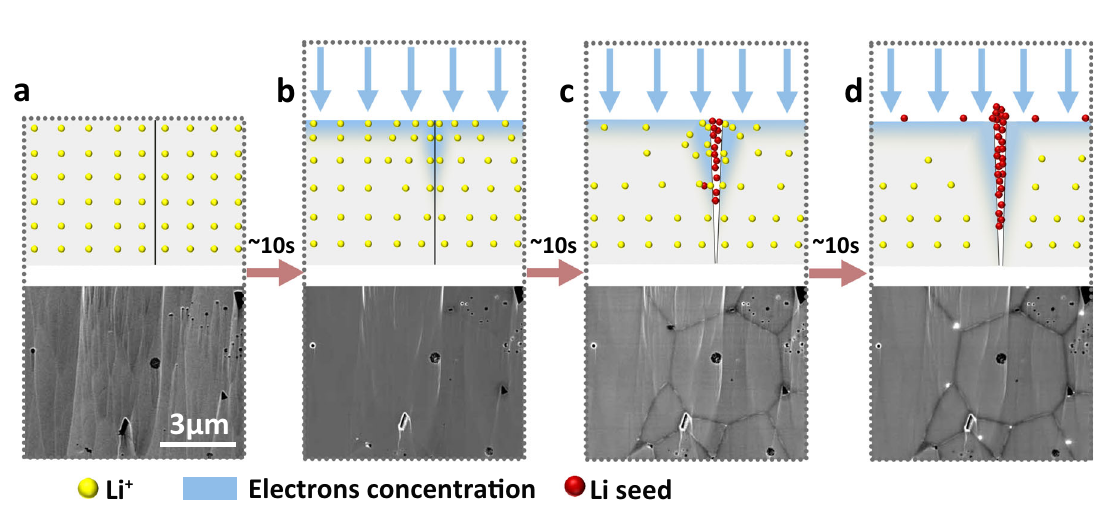
Fig.6|Lithiumexpulsionsformationprocessatgrainboundaries.a – d Schematicdiagramoftheformationofmetal-lithiumparticlesonLLZOsurfaceduringelectron- beam injection with a time step around